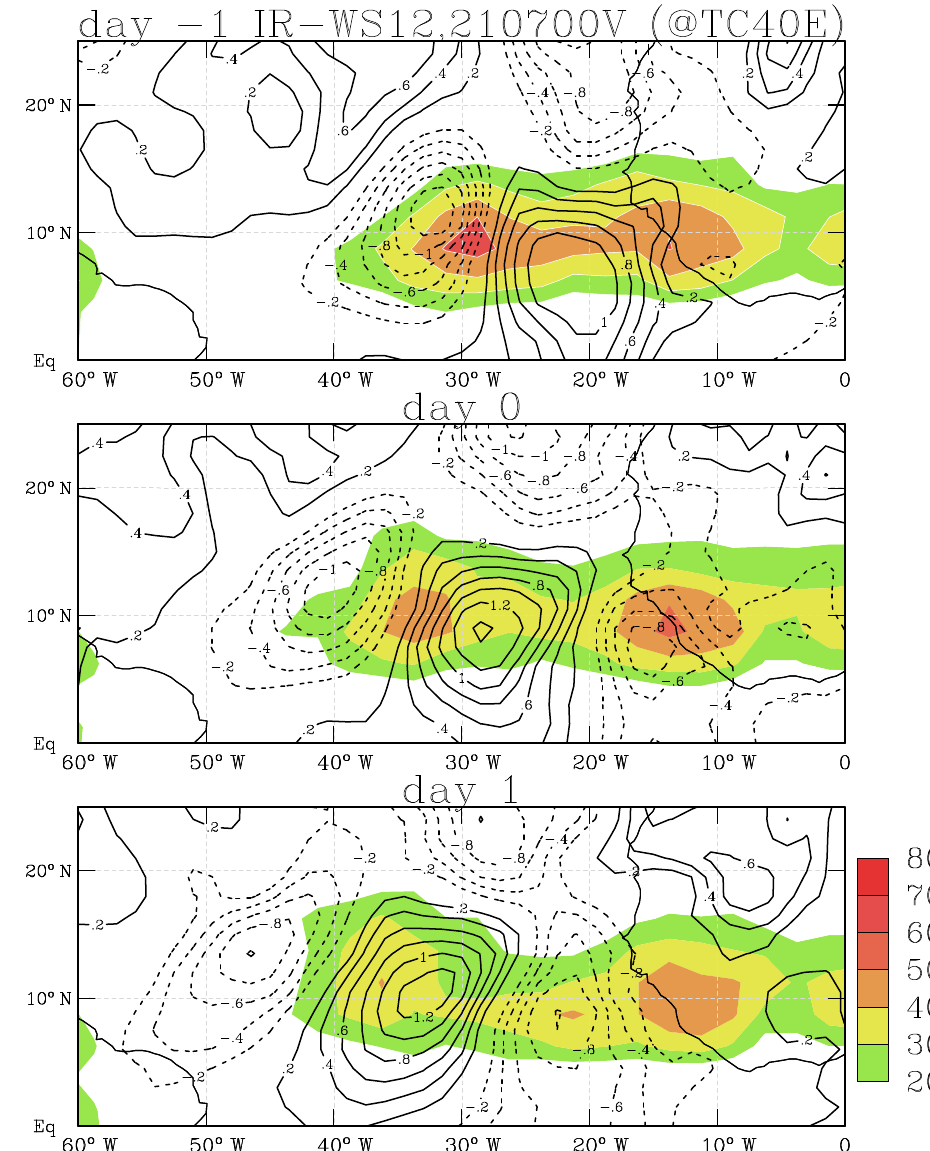
Figure 8. Composites of IR-WS12 (shaded every 10% from starting from 20%) and 2–10 day filtered 700 hPa meridional wind (contoured every 0.2 m/s). Composites are constructed based on dates of tropical cyclone genesis over the region 40°–20° W.